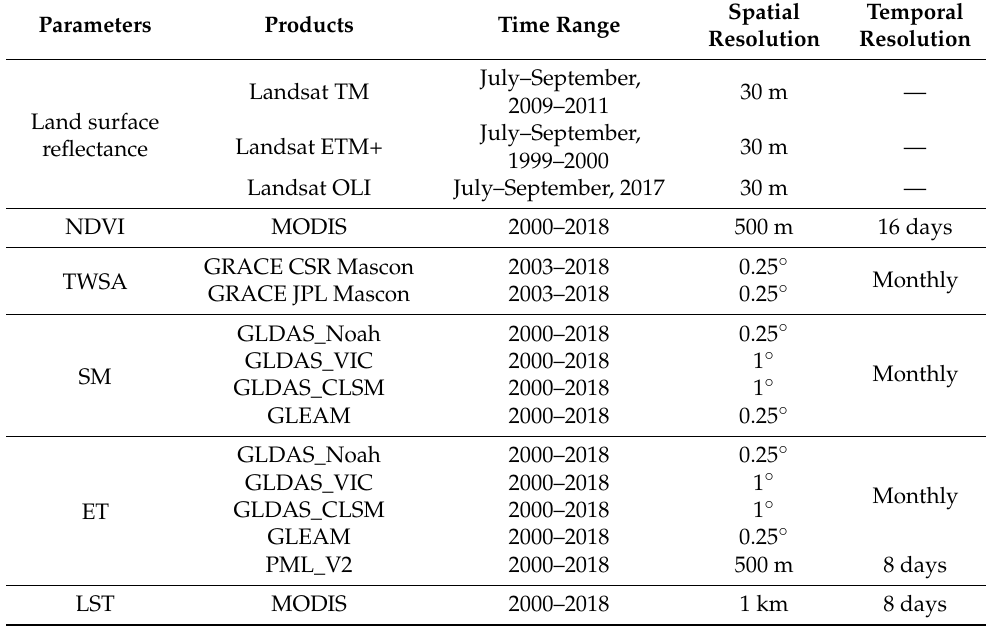
Table 1. Remote sensing products of eco-hydrological parameters used in this study.